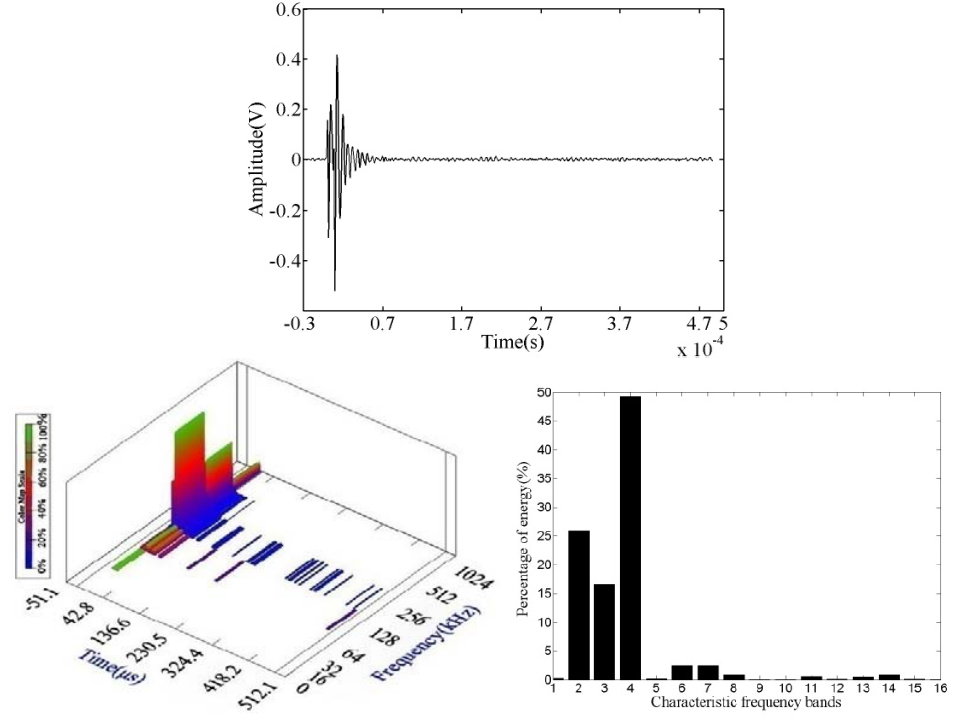
Figure 8. Steel wires failure AE waveform and wavelet packet analysis. ( a ) Waveform 1; ( b ) Waveform